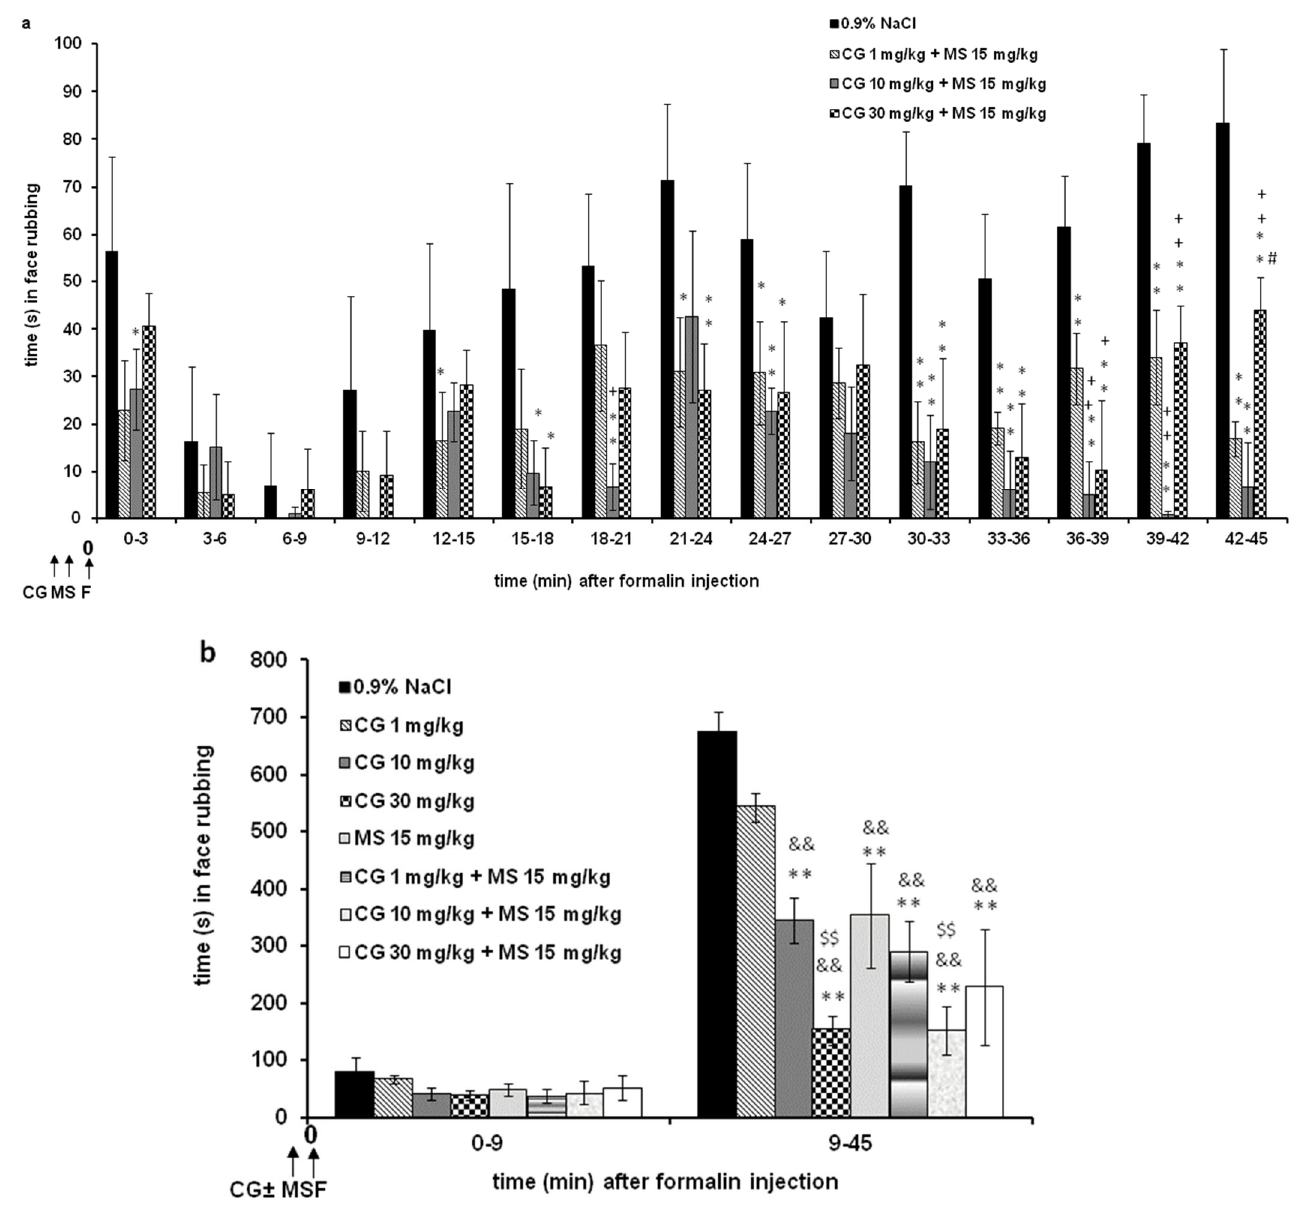
Figure 3. The antinociceptive effect of cromoglycate (CG)–magnesium sulfate (MS 15 mg/kg) in the formalin orofacial test in rats. Each bar represents the mean time (in seconds) of face rubbing ± SD observed in 6 rats. Time intervals of nociceptive response (face rubbing) in 3 min intervals are shown in graph ( a ), and the total time spent in the nociceptive response in phase 1 (0–9 min) and phase 2 (9–45 min) in the formalin test is shown in graph ( b ). Statistical significance (two ‐ way ANOVA followed by Tukey’s HSD) was determined by comparing with the control (0.9% NaCl; n = 6) (* p < 0.05, ** p < 0.01), + p < 0.05, ++ p < 0.01 in comparison with CG 1 + MS 15 ( n = 6), # p < 0.05 in comparison with CG 10 + MS 15 ( n = 6), && p < 0.01 in comparison with CG 1 ( n = 6), and $$ p < 0.01 in comparison with CG 10 ( n = 6).